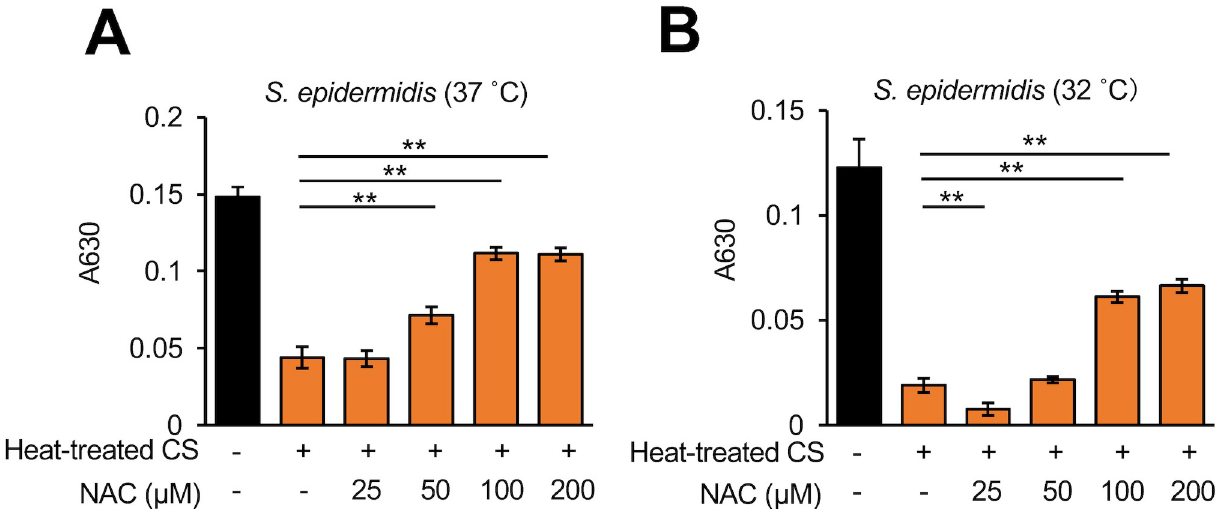
Fig 6. Suppressive effect of N -acetyl-L-cysteine on the inhibitory activity of heat-treated culture supernatant of D . acidovorans against S . epidermidis growth. S . epidermidis (1 × 10 4 cells/mL) in NB was mixed simultaneously with 15% D . acidovorans heat-treated CS (Heat-treated CS) and 25–200 μ M N -acetyl-cysteine (NAC). After incubating at 37˚C for 12 h (A) or 32˚C for 18 h (B), absorbance at 630 nm was measured using a microplate reader. Error bars indicate the SD of the means (n = 3). Statistical differences between groups were analyzed by the Tukey-Kramer test. ( � : P < 0.05, �� : P <